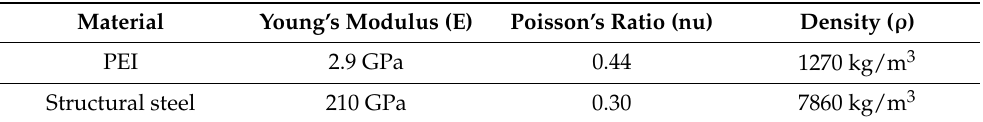
Figure 6. ( a ) System modeled by finite elements for the verification of the analytical mode. ( b ) Hexag- onal cone membrane-type acoustic metamaterials. Table 1. Material parameter